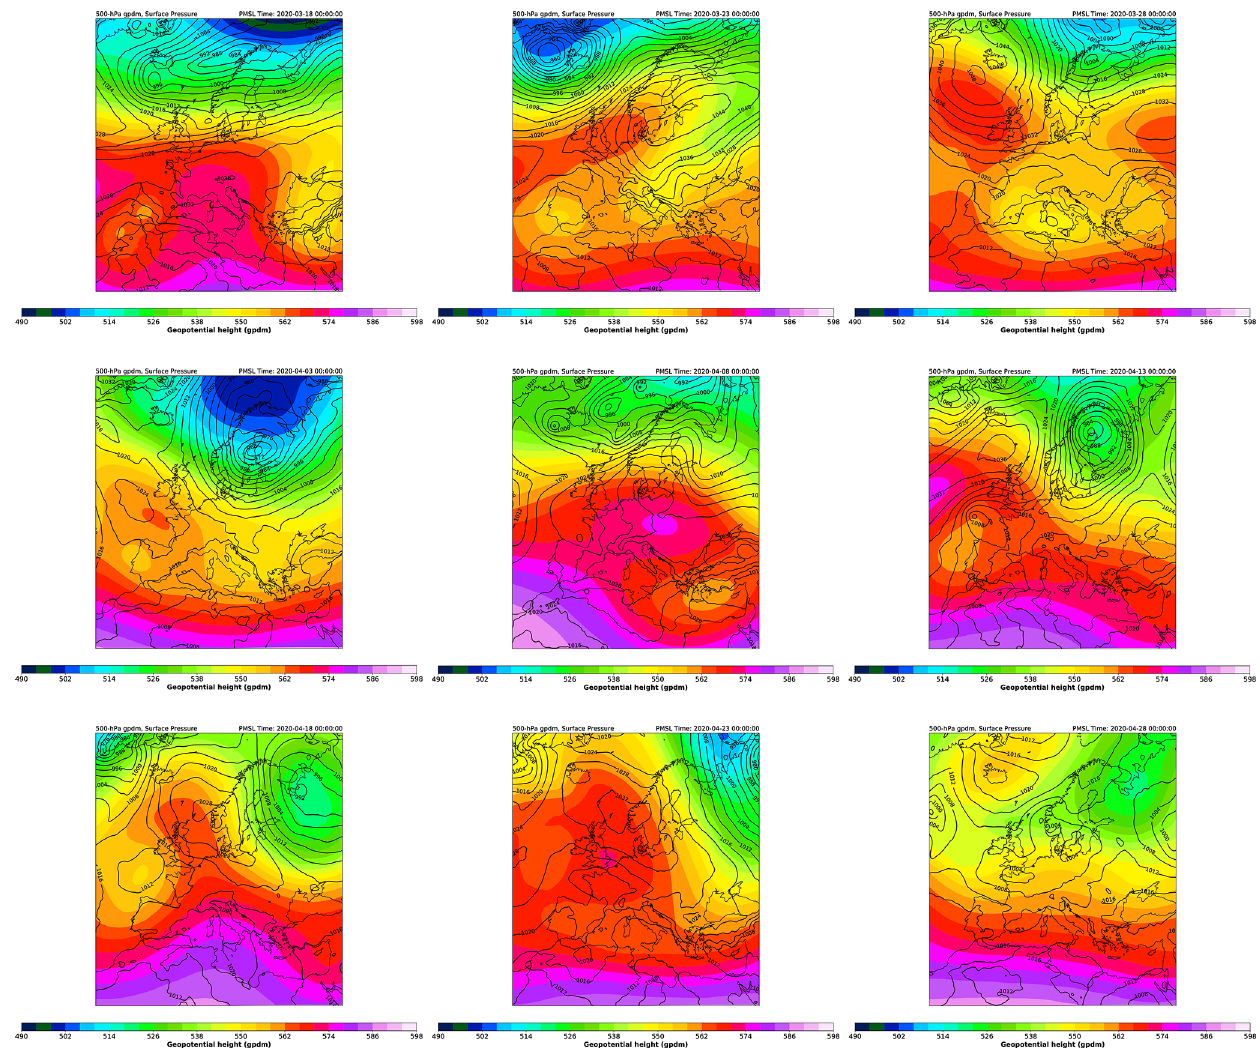
Figure A5. 500hPa geopotential heights (in gpdm) and surface pressure (in hPa) for 4d time segments in March and April 2020 according to the COSMO simulations. The geopotential heights are averaged over 4d, and displayed surface pressure distributions are representative snapshots within those time